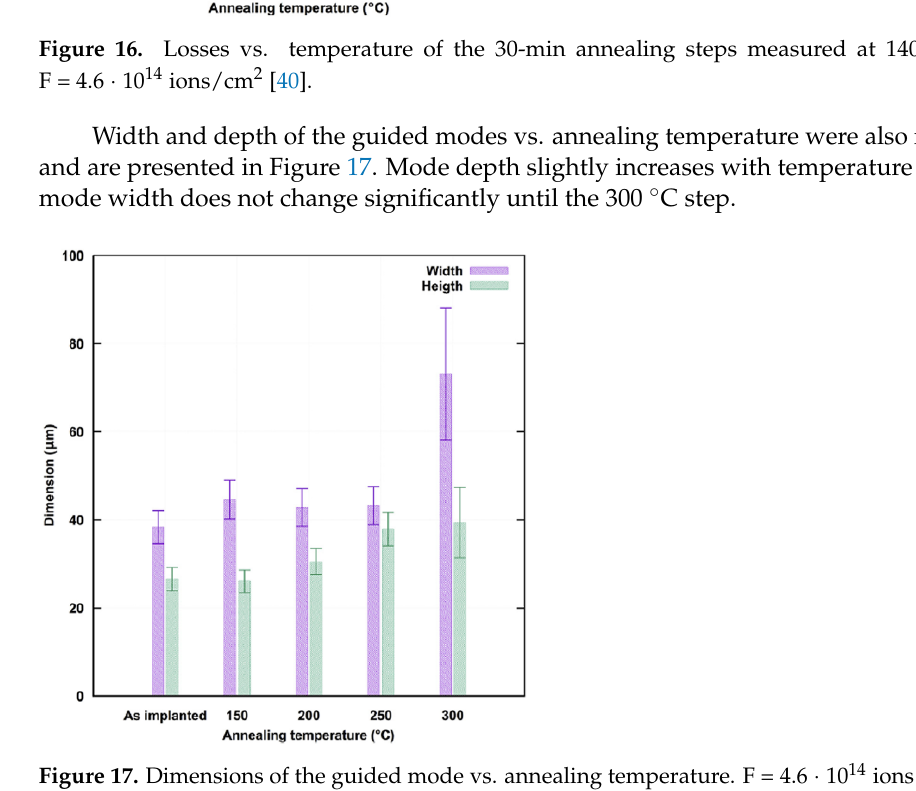
Figure 17. Dimensions of the guided mode vs. annealing temperature. F = 4.6 · 10 14 ions/cm 2 [40].